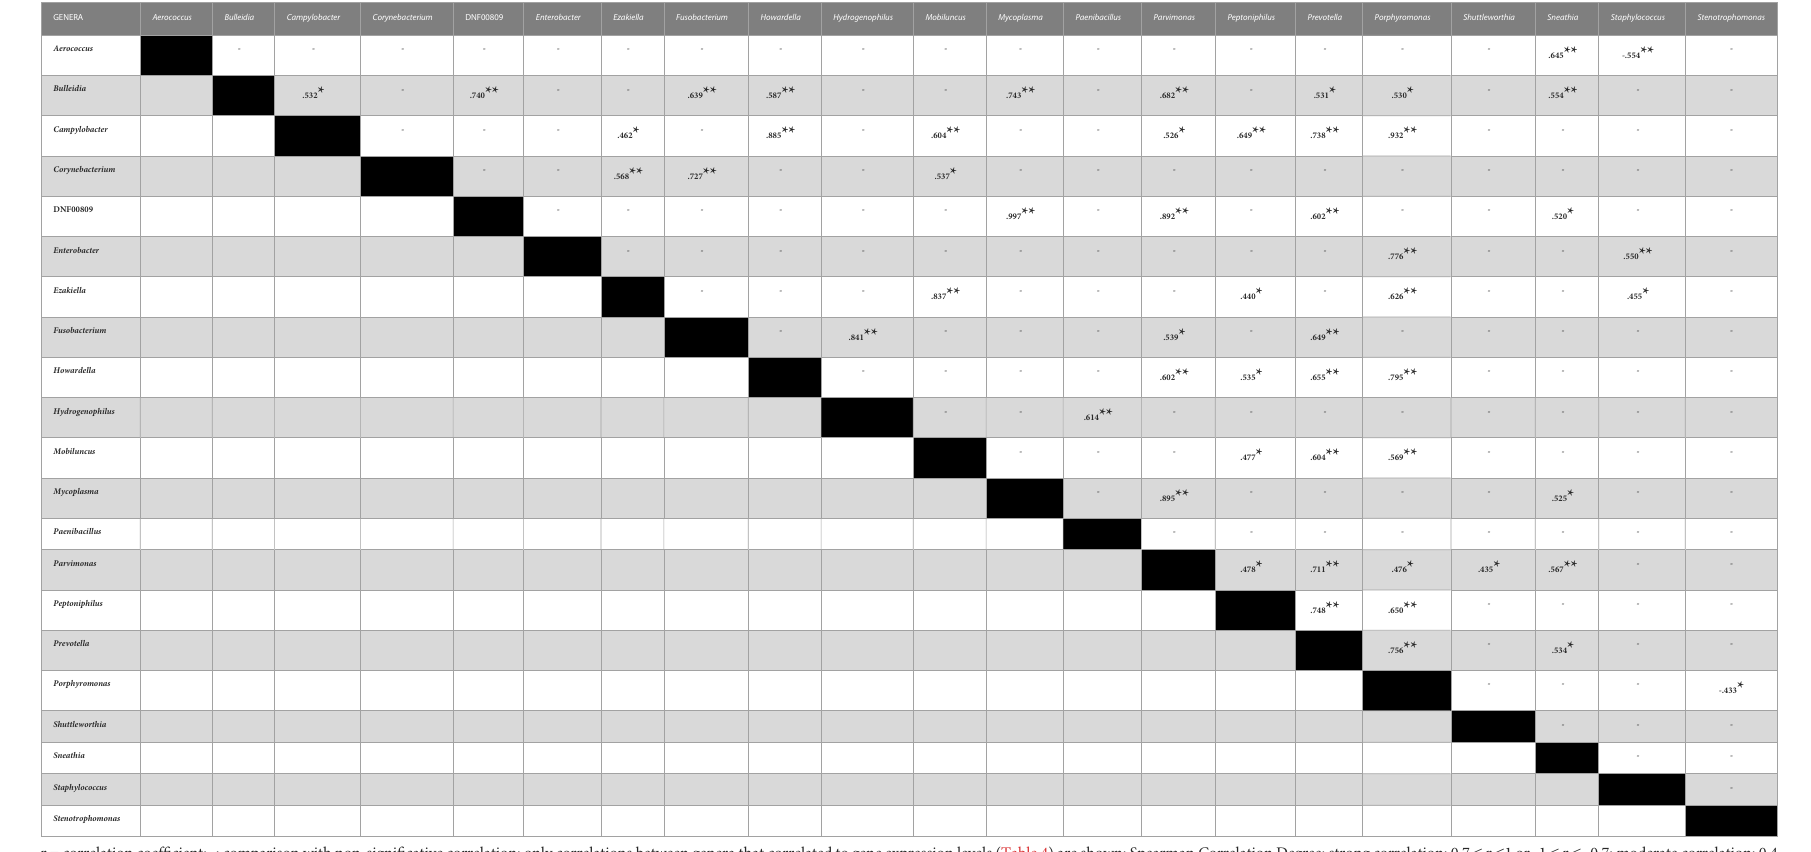
TABLE 5 Correlation analysis between bacterial genera abundance.